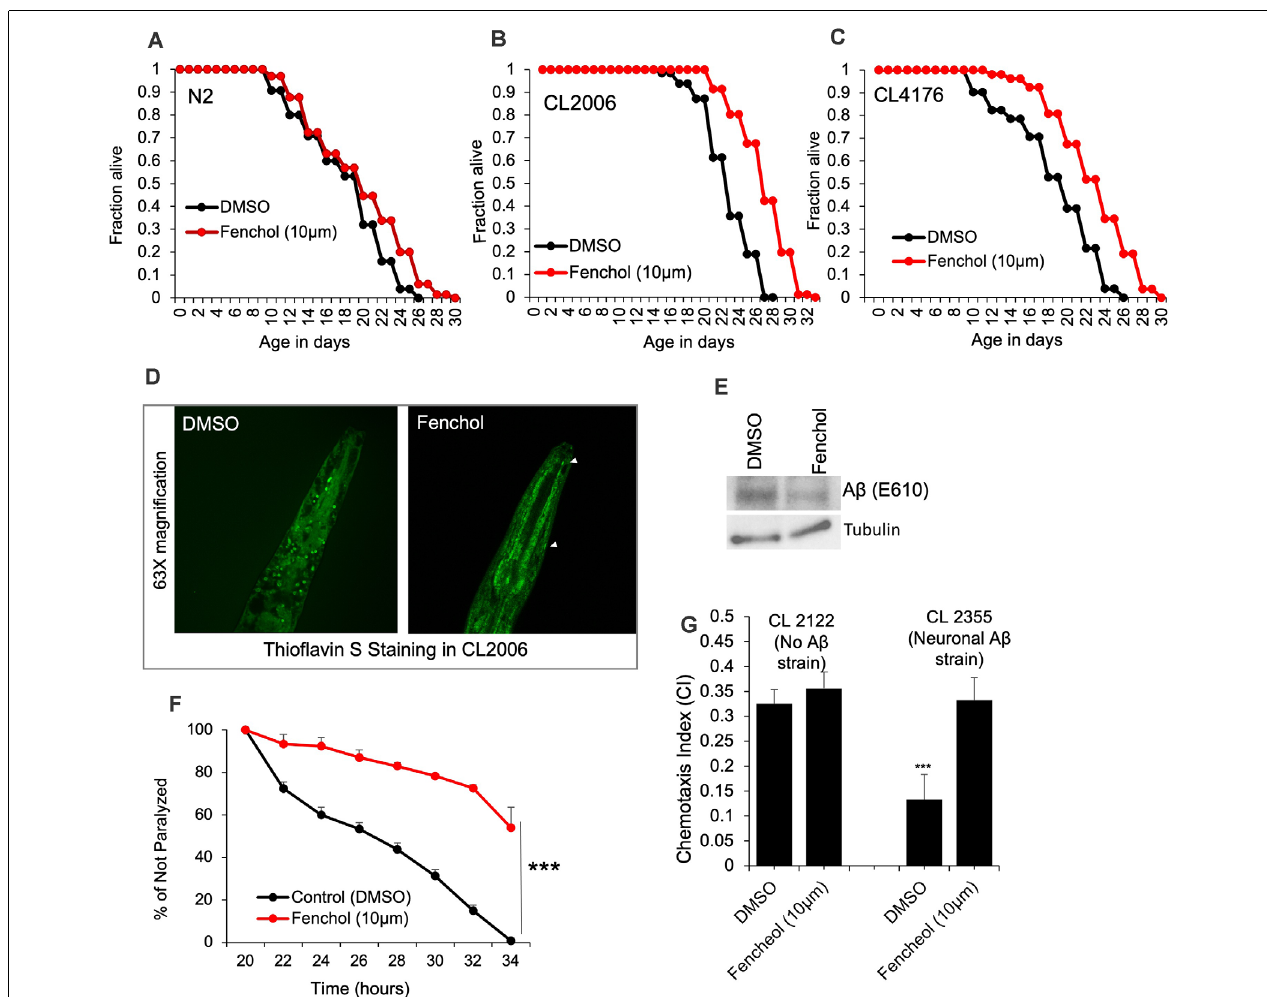
FIGURE 4 | Fenchol significantly increased lifespan in human A β -over-expressing C. elegans . (A–C) Lifespan assay of wild-type (A) and human A β -overexpressing (CL2006 and CL4176) (B,C) with and without Fenchol treatments. (D,E) A β accumulation shown by thioflavin S staining (D) and western blot (E) in CL2006 worms treated with Fenchol in comparison to their DMSO treated controls. (F) Fenchol protected temperature-induced A β -mediated paralysis in CL4176 strains compared to their DMSO treated control group. (G) In addition, Fenchol treatment preserved temperature-induced A β overexpression mediated chemotaxis index (a markers of cognition/ memory) in CL2355 strain of C. elegans compared to their DMSO treated control, while Fenchol show normal effects in control CL2122 strain of C. elegans . Data are mean ± SEM ( n =3 independent experiments in triplicate). *** P <